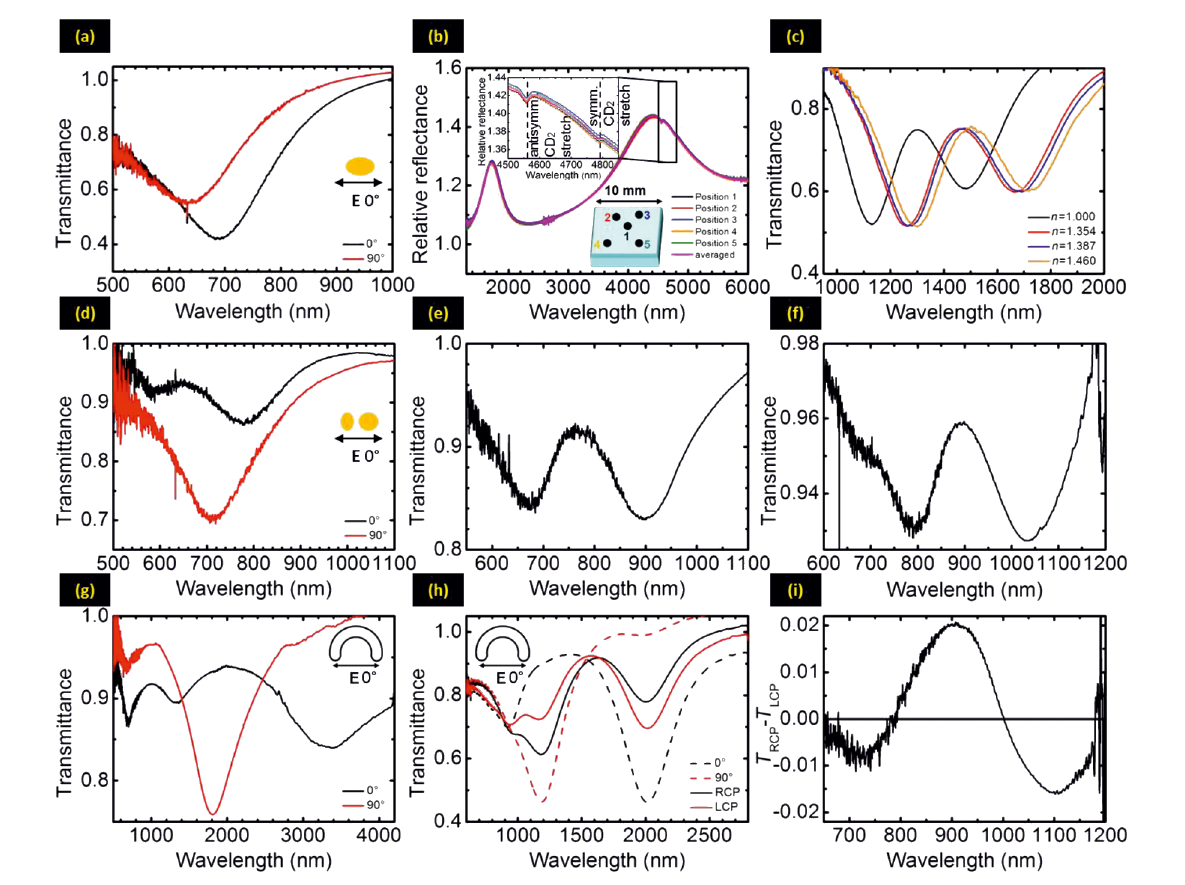
Figure 5: Optical spectra of the fabricated nanostructures as shown in Figure 4. The measurements are performed with a Fourier transform infrared spectrometer under normal incidence. Detailed descriptions see text.